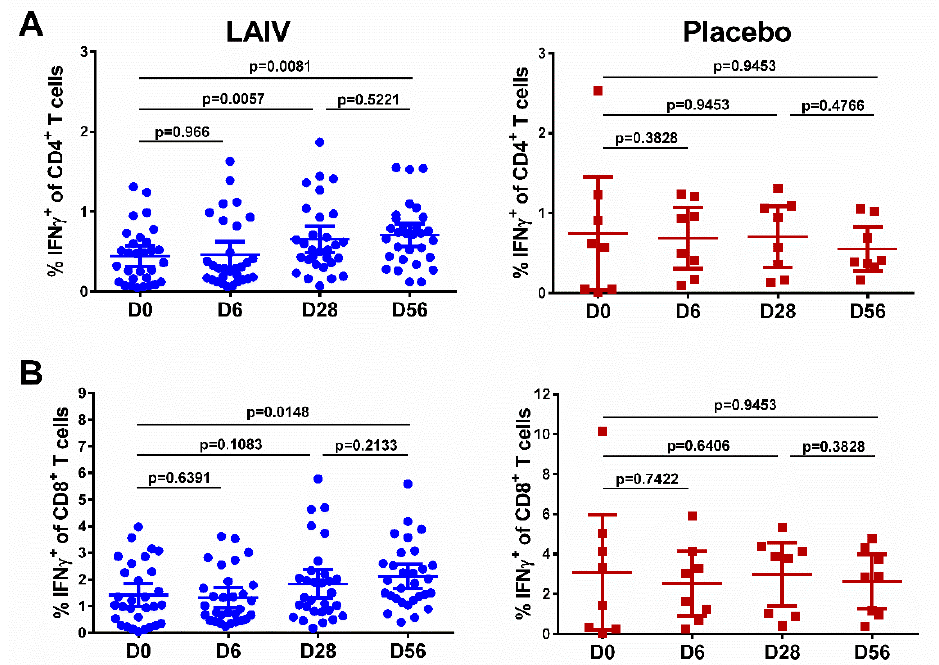
Figure 4. Cell-mediated immune responses in subjects before and after administration of H7N9 LAIV or placebo (given on day 0 and day 28). ( A ) CD4 + T-cell responses. ( B ) CD8 + T-cell responses. Individual data are shown, along with means ± 95% CI. T cell levels at different time-points were compared using the Wilcoxon matched-pairs test. The exact two-sided p values are shown.